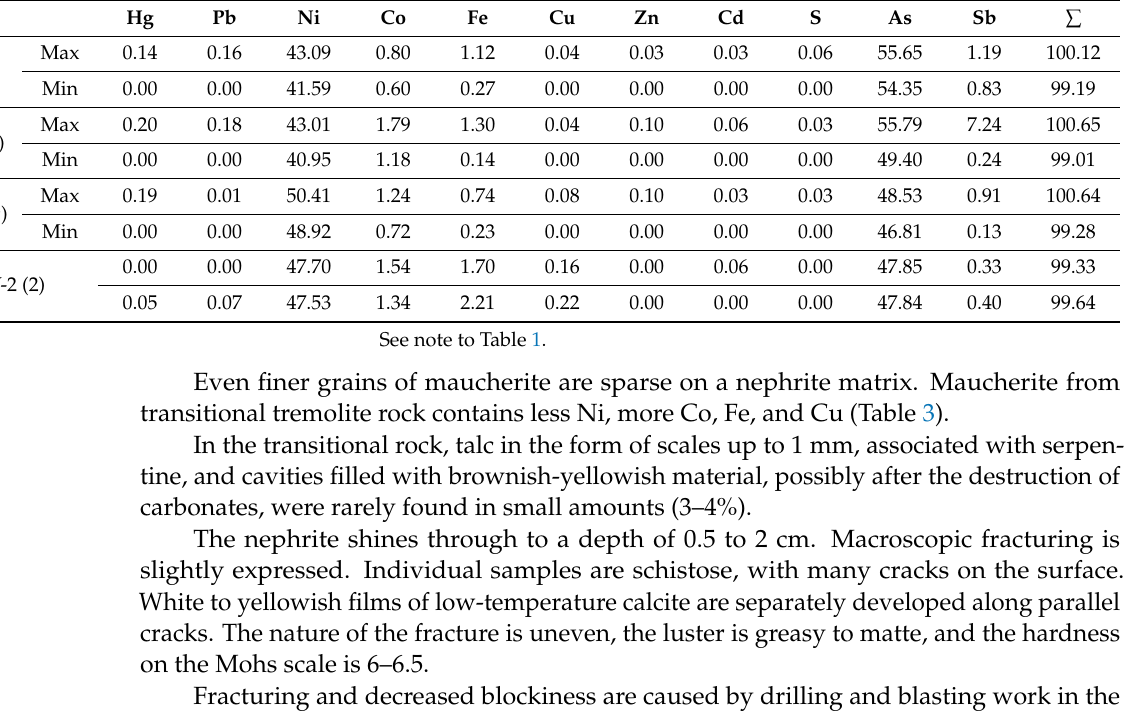
Table 3. Chemical composition of arsenides (wt. %).